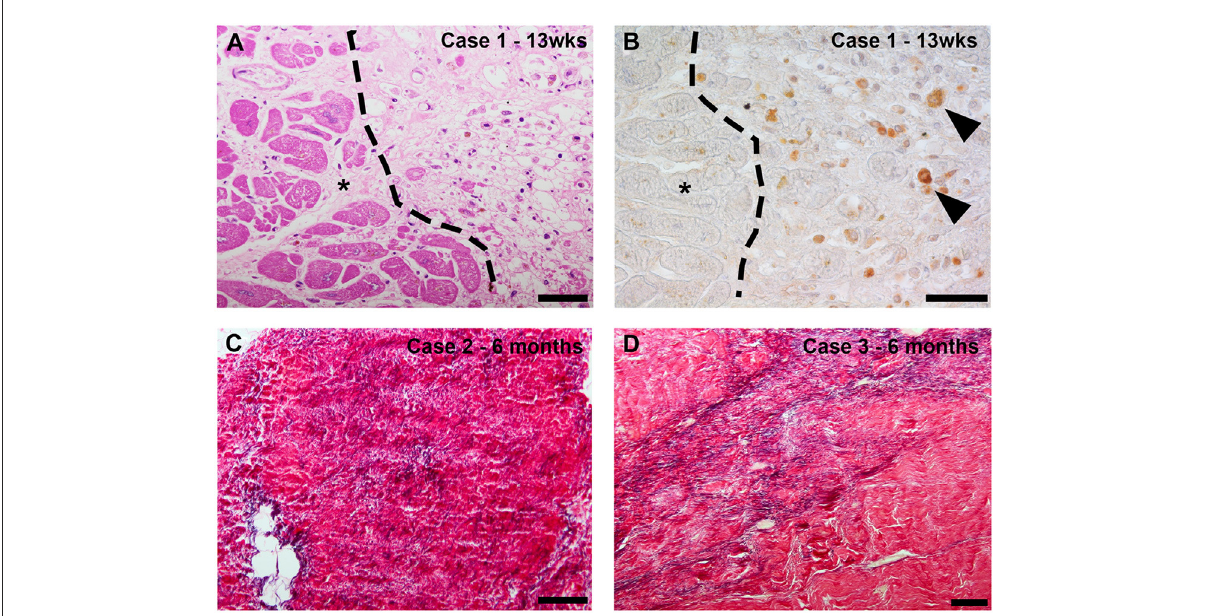
FIGURE3 (Reproduced with permission from Kautzner et al. (32)–case numbers and details are described in referenced article): Case 1 (13 weeks after stereotactic body radiotherapy [SBRT]): routine histologic evaluation revealed myocytolysis corresponding to a previously irradiated region with a sharp transition to viable myocardium (*) (A) . Detection of active caspase-3 as a marker of apoptosis revealed intracellular immunoreactivity in the cytoplasm of rounded cells that morphologically corresponded to macrophages. * marks viable myocardium (B) . Case 2 (6 months after SBRT): histologic staining of the irradiated area revealed fibrotic region containing densely packed fibers, including a relatively high elastic component (C). Case 3 (9 months after SBRT): histologic staining of the irradiated region revealed myocardial scarring with marked elastosis (D)